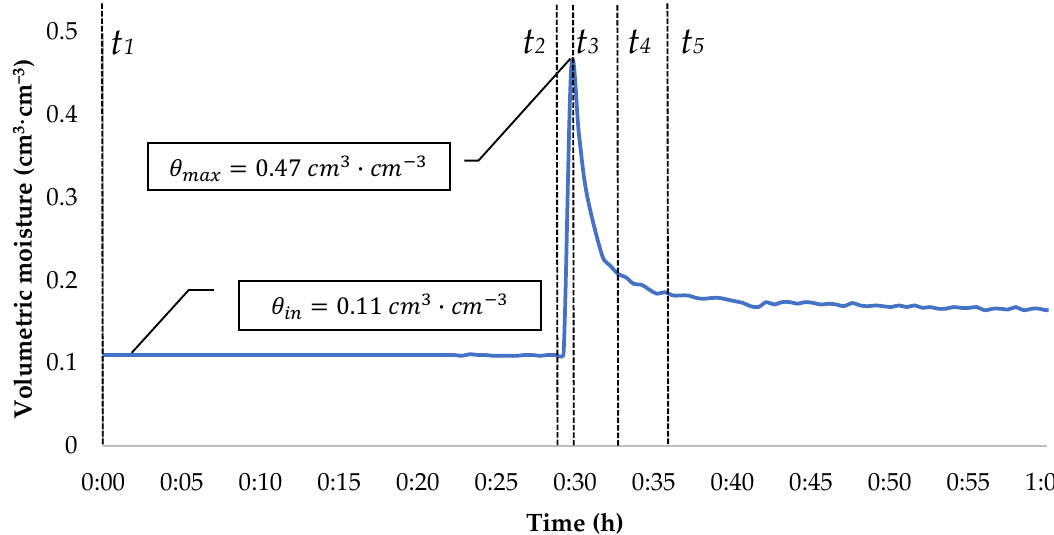
Figure 5. Dynamics of volumetric moisture in a selected elementary volume during injection of 1500 cm 3 of water.